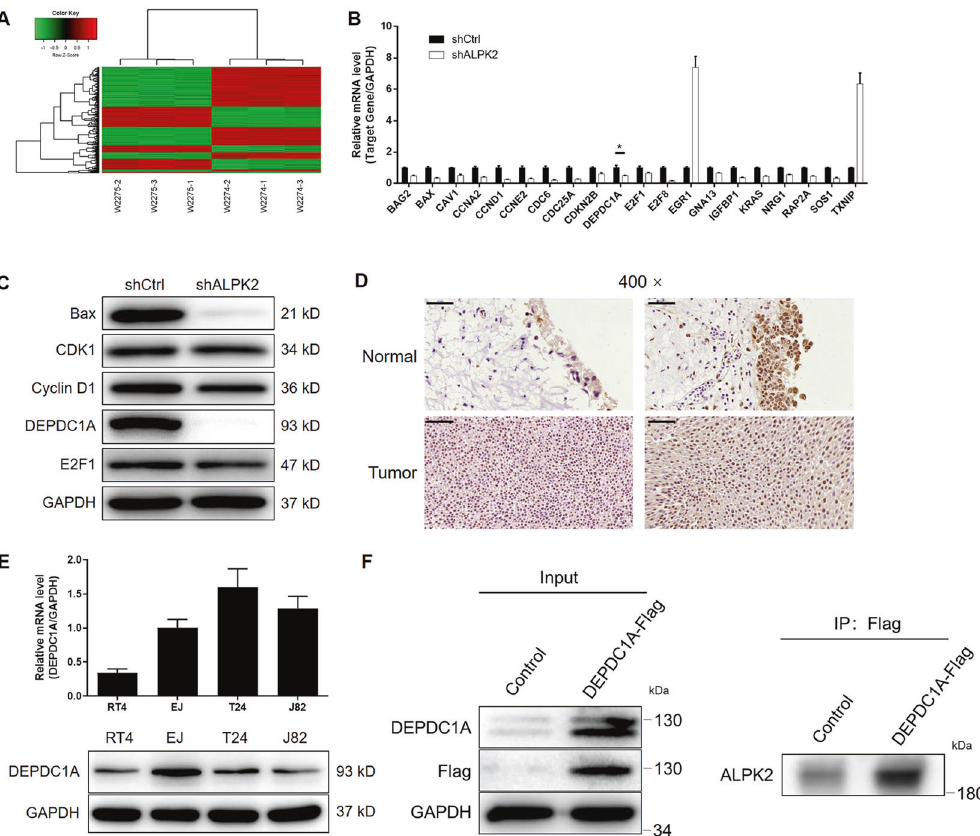
Fig. 4 The exploration and veri fi cation of downstream underlying ALPK2 induced regulation of bladder cancer. A A PrimeView Human Gene Expression Array was performed to identify the differentially expressed genes (DEGs) between shALPK2 and shCtrl groups of T24 cells. qPCR ( B ) and western blotting ( C ) were used to detect the expression of several selected DEGs in T24 cells with or without ALPK2. D The expression of DEPDC1A in bladder cancer tissues and normal tissues was evaluated by IHC analysis (scale bar = 50 μ m in 200 magni fi cation, scale bar = 20 μ m in 400 magni fi cation). E The mRNA and protein expression of ALPK2 in EJ, T24, J82, and RT4 cell lines was detected by qPCR and western blot, respectively. F The interaction between ALPK2 protein and DEPDC1A protein was con fi rmed by co-immunoprecipitation assay. The representative images were selected from at least three independent experiments. Data were shown as mean ± SD. * P <